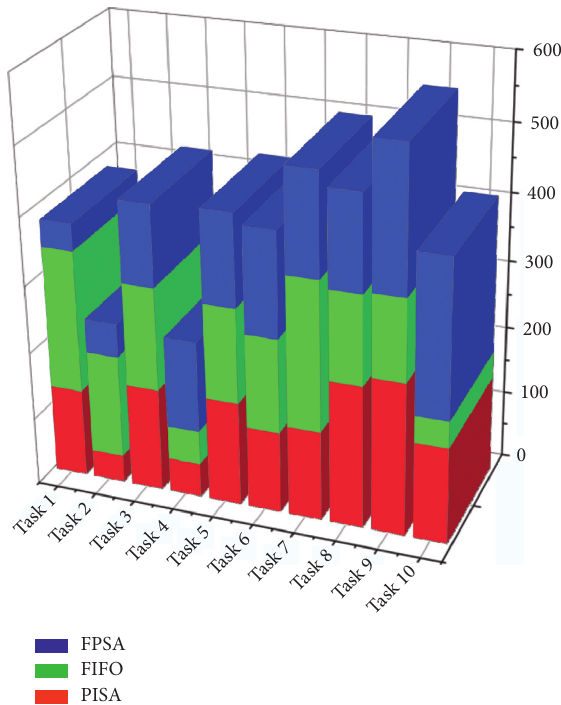
Figure 9: Comparison chart of execution time experiment results.